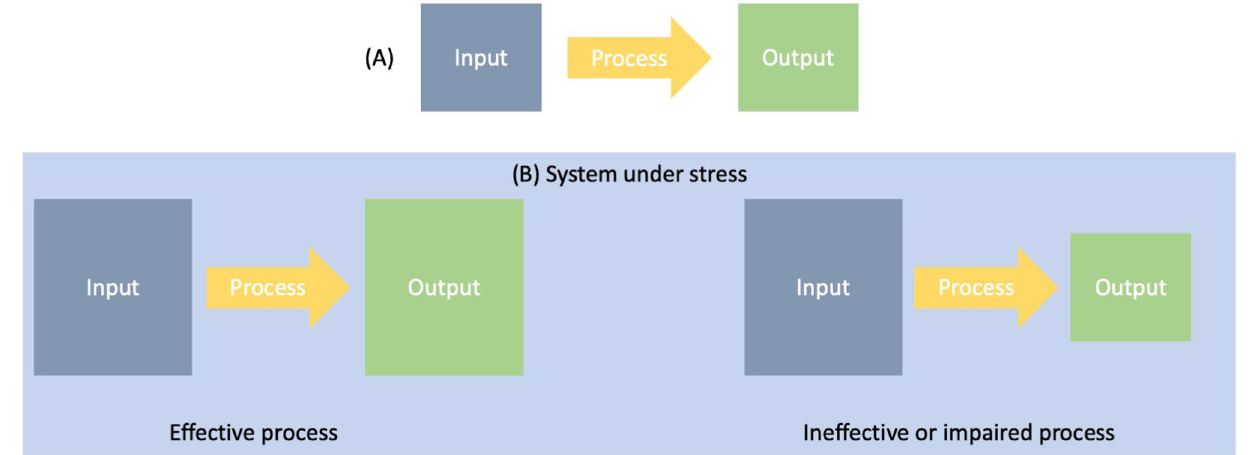
Fig. 2 Assessment of the effectiveness of a process. a Effectiveness of a process is measured by the output which is dependent on the input. b During period of stress, an effective process will be able to produce a higher output with the same volume of input